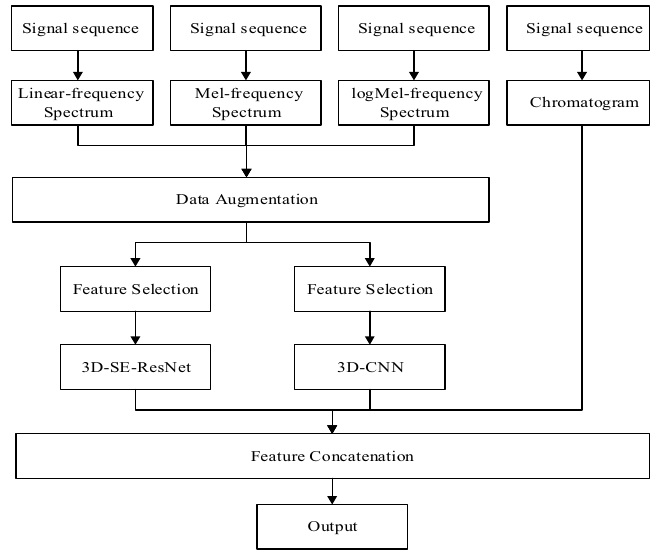
Figure 6. Flowchart of the proposed multi-input 3D model for environmental sound classification.